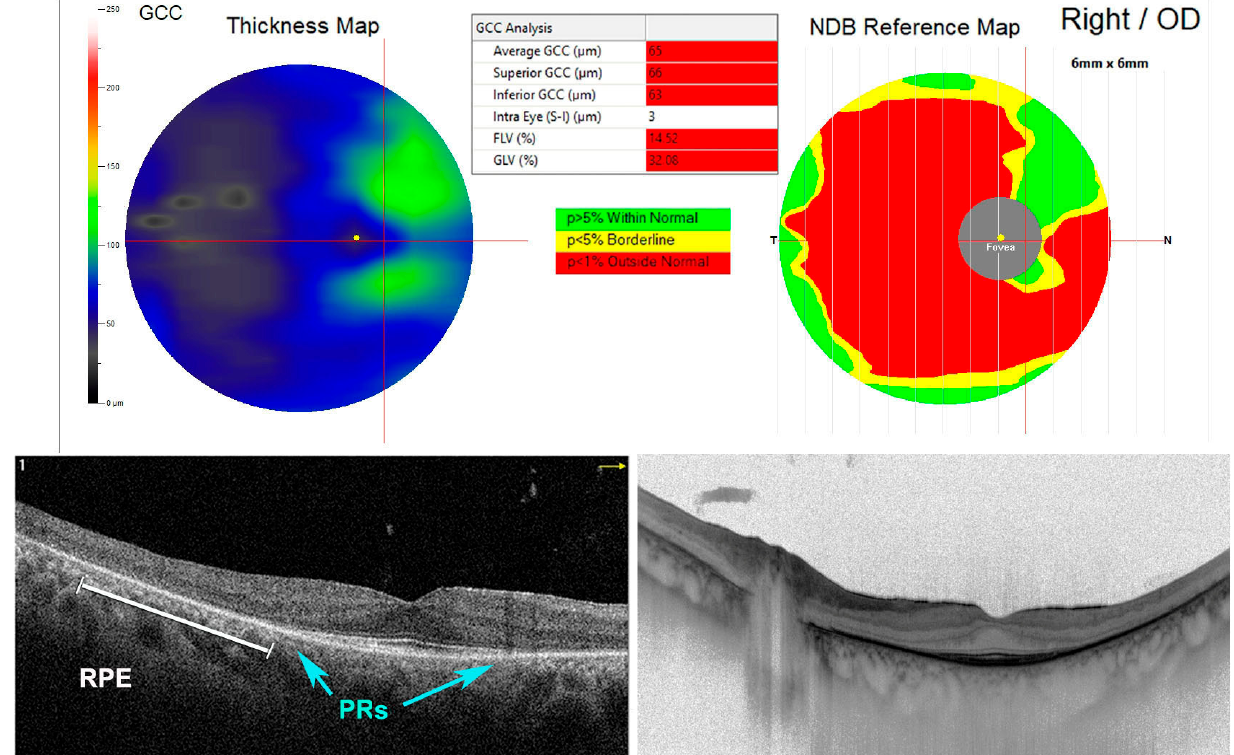
Figure 4. Spectral domain-optical coherence tomography (SD-OCT) of a patient with retinitis pigmentosa (RP). In right eye, it is possible to notice the absence of photoreceptors (PRs) (blue arrows) and a retinal pigment epithelium (RPE) degeneration (white line) beyond the perifoveal area. Thinned ganglion cell complex (GCC thickness map). Outside normal retinal thickness distribution was established by the normative database reference map (NDB reference map).